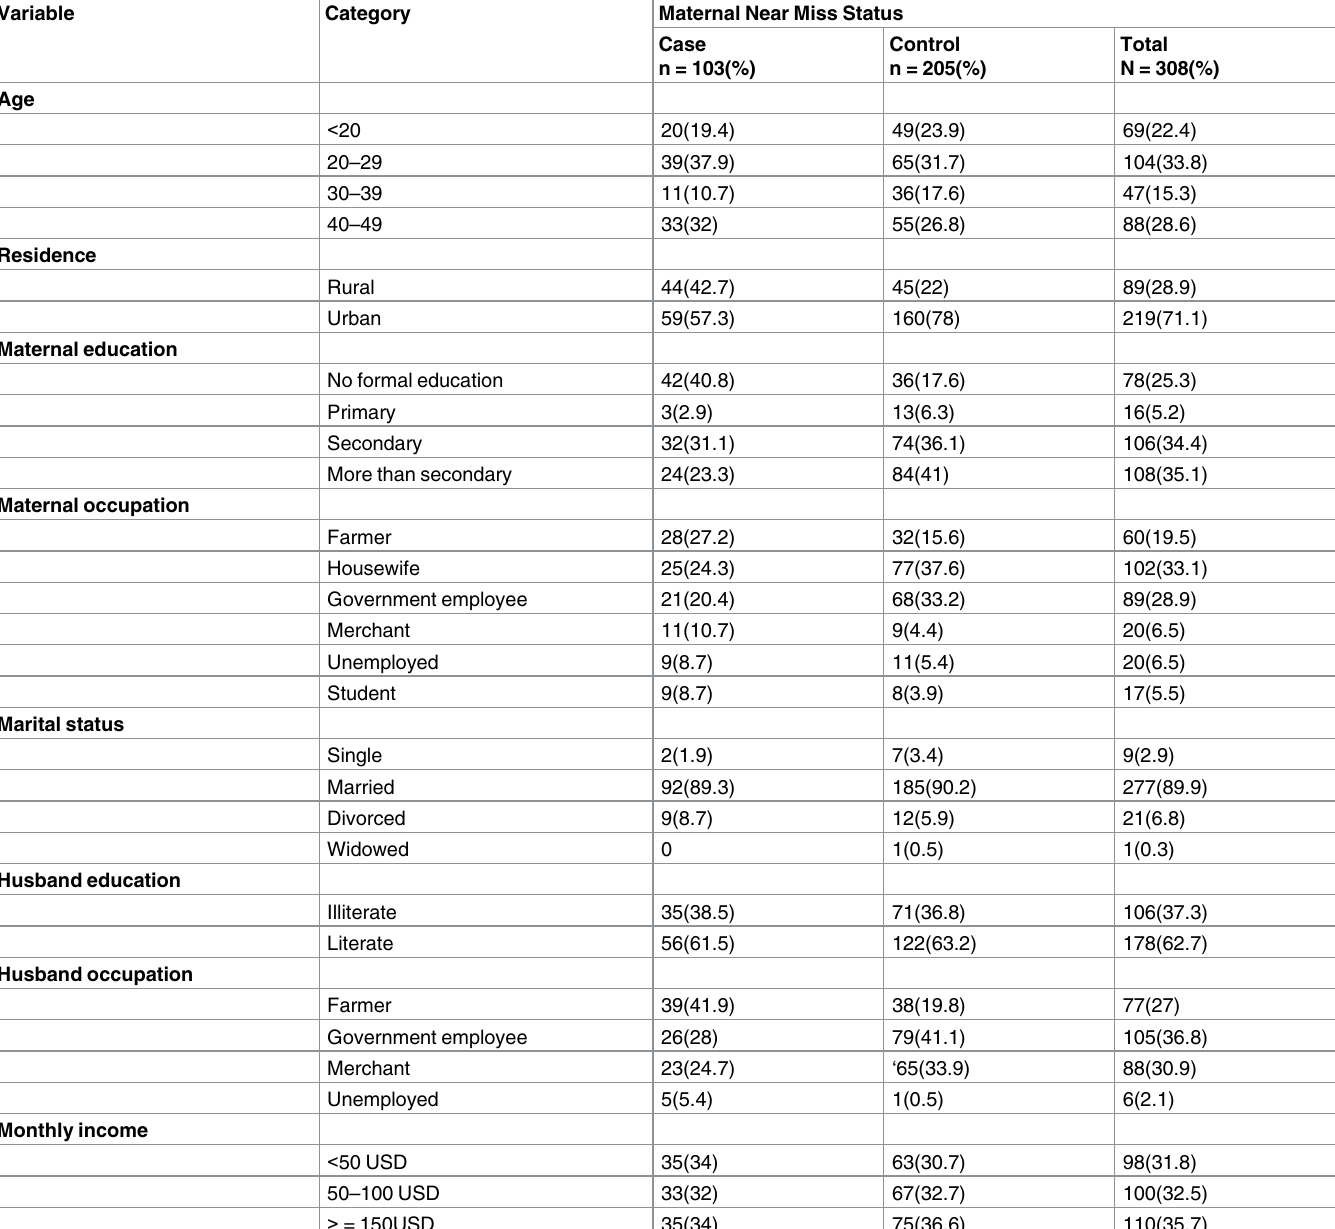
Table 1. Socio-demographic characteristics of mothers admitted to public hospitals, Tigray, Northern Ethiopia, 2016. (N = 308).